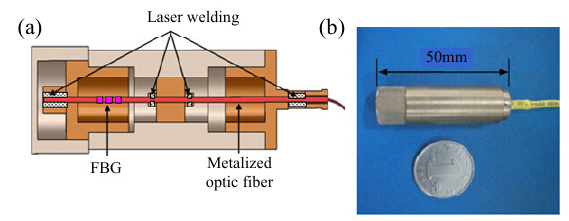
Fig. 22 FBG acceleration sensor: (a) metallic packaging structure and (b) actual image of the FBG accelerometer.